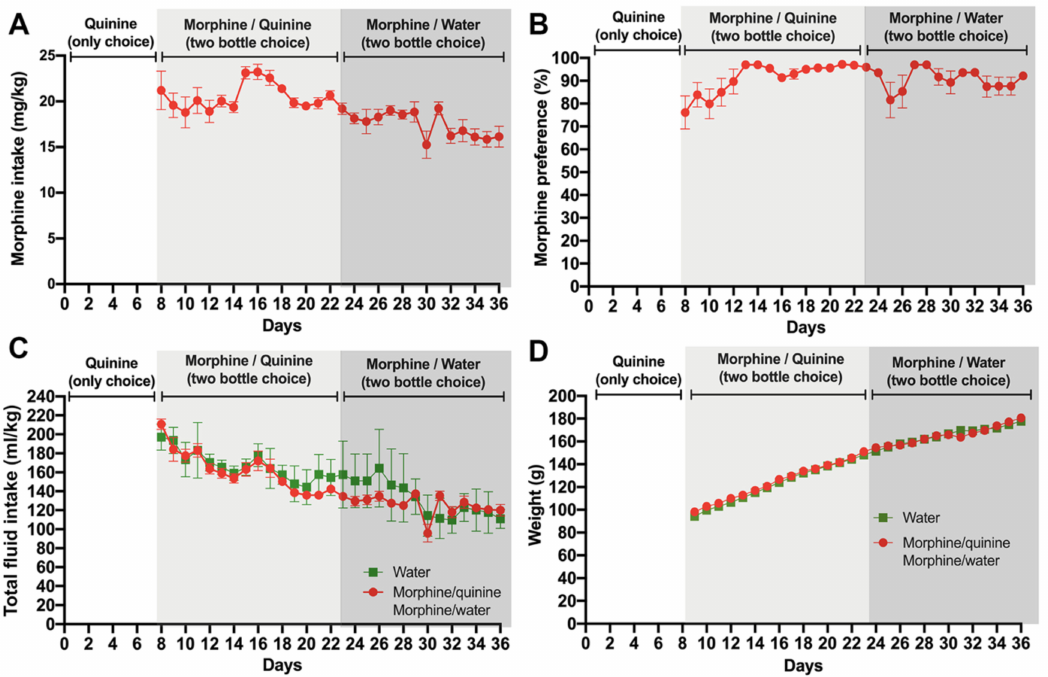
Figure 2. Voluntary morphine intake by Wistar rats. One week after starting quinine intake (Figure 1), animals were exposed to 0.15 mg/mL quinine and 0.15 mg/mL morphine for two weeks using the two-bottle choice paradigm. Thereafter, animals were exposed to 0.15 mg/mL morphine and water (two-bottle choice) for two additional weeks. ( A ) Voluntary morphine intake is expressed as mg morphine consumed per kg of body weight per day. ( B ) Morphine preference (%). ( C ) Total fluid intake expressed as total fluid consumed per kg of body weight/day. ( D ) Animal weights. Data are expressed as mean ± SEM. n = 8 in the water group, and n = 18 in the morphine group; 38% of the animals in the morphine group were excluded since they did not show >50% morphine preference against